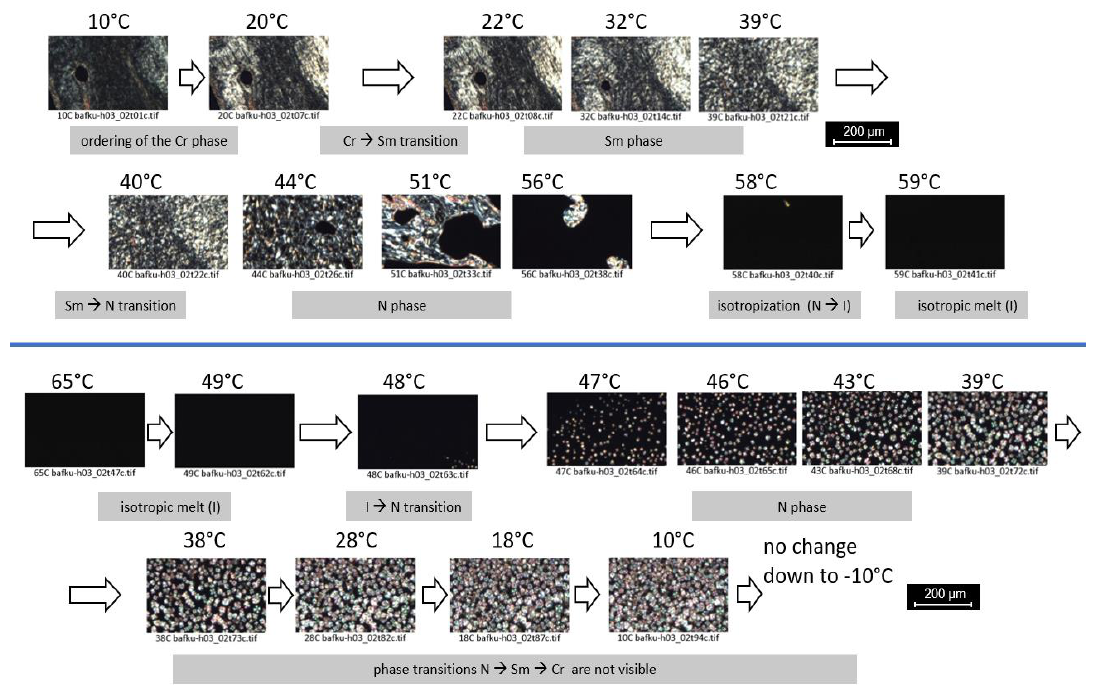
Figure 6. Textures observed in BAFKU–H03. Top : heating run; bottom : cooling run; large representative images of each characteristic texture are shown in the Supplementary Materials, SI Figures S22–S24.